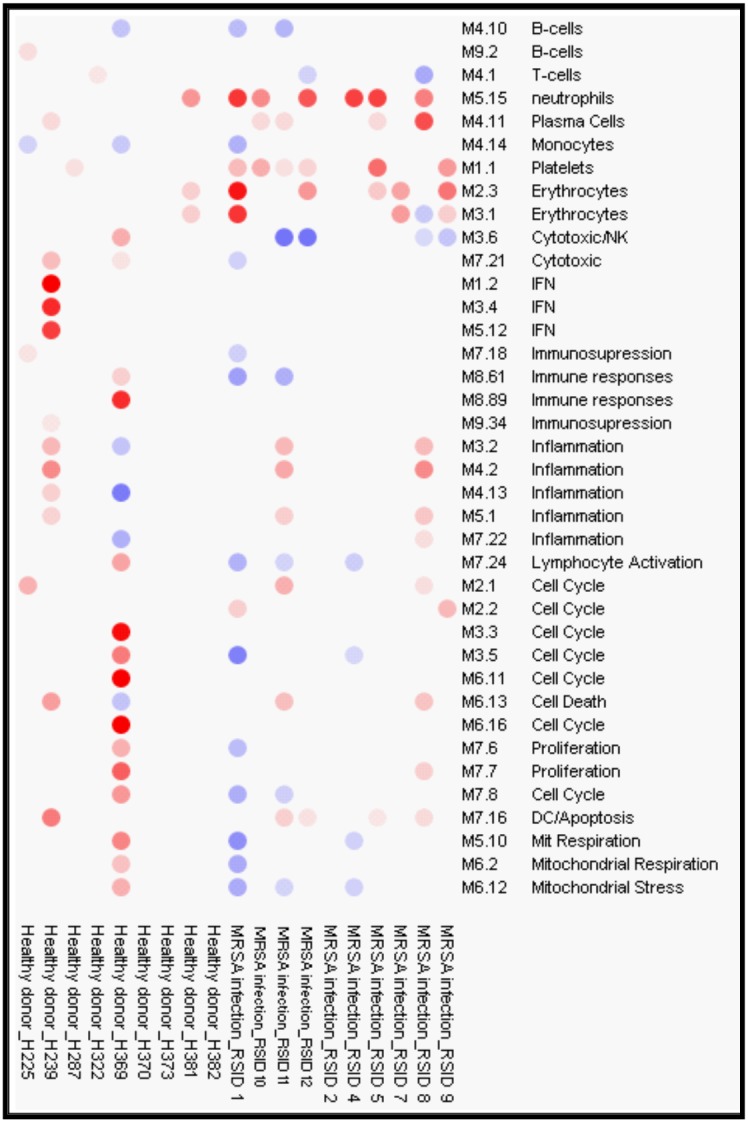
Module Analysis of Gene Expression Profile in Whole Blood From Patients with MRSA AHO.Gene expression in one of the subjects within the healthy control group revealed an unusual array of cellular expression. This subject was excluded and microarray statistical analysis was repeated without his information. Gene expression levels were compared between healthy controls and patients with MRSA AHO on a module by module analysis. Each column represents a subject and each row a cell type. Colored spots represent the percentage of significant over-expressed (red) or under expressed (blue) transcripts (Mann-Whitney p<0.05). The intensity of the color refers to the number of transcripts within each of the pre-selected modules not the actual fold change that is up or down regulated compared to healthy controls. Modular analysis identified that patients had upregulation of innate immunity and mild downregulation of adaptive immunity.